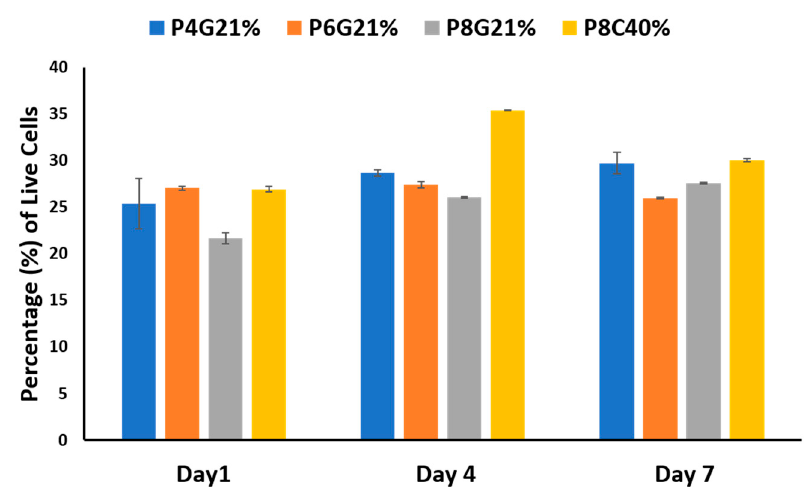
Figure 7. Cell viability of Fibroblast cells by MTT assay.